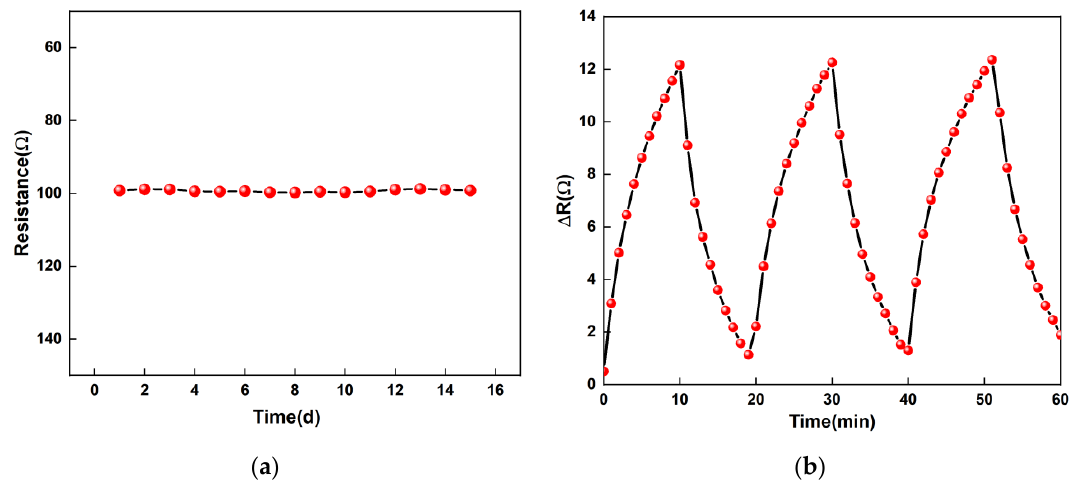
Figure 9. The repeatability and stability of the sensor. ( a ) The stability of the sensor with time. ( b ) The repeatability of the sensors with time.